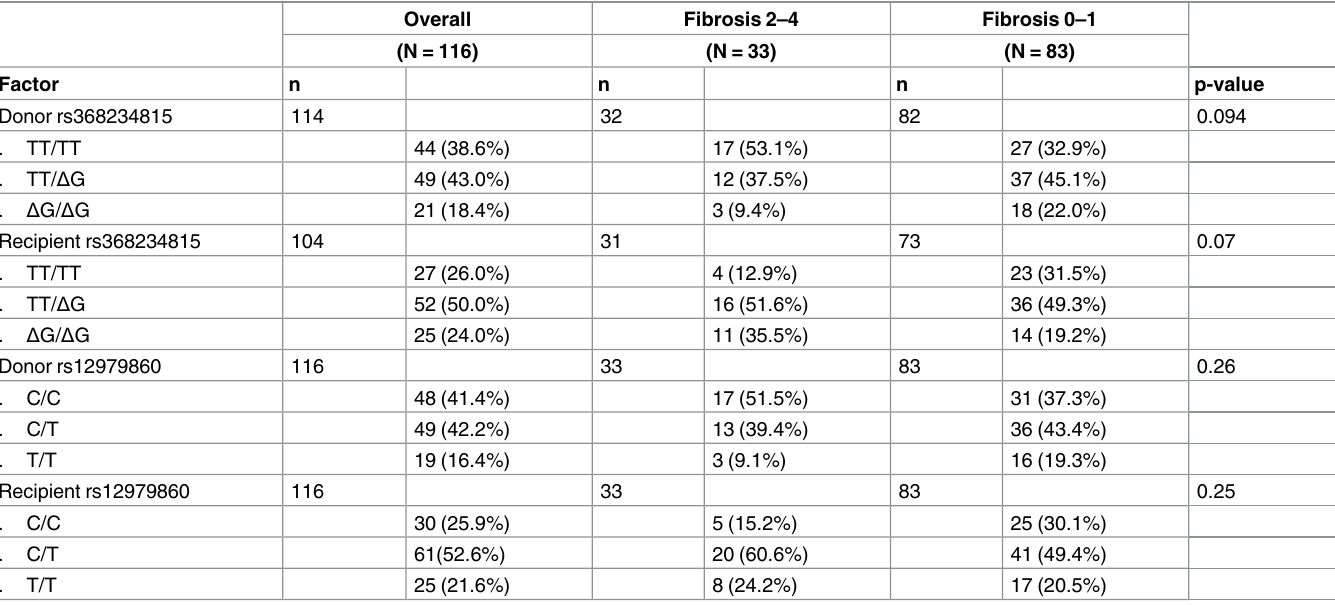
Table 2. Allele Frequency for Patient Population.